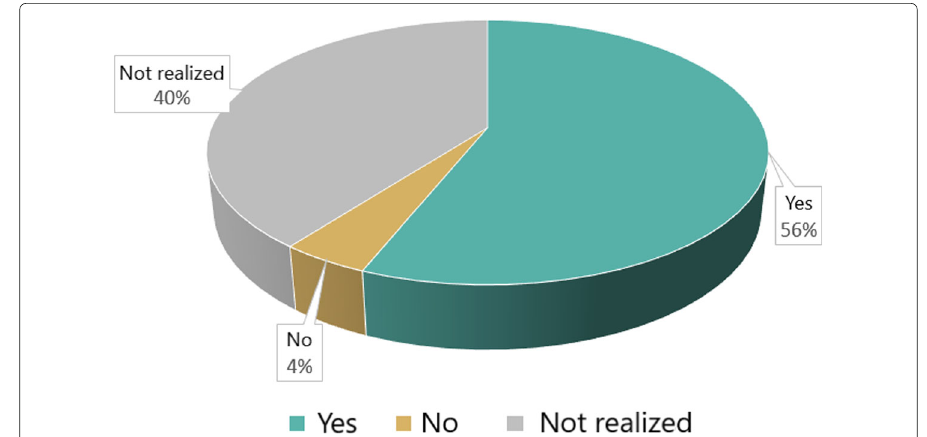
Fig. 7 User satisfaction. Answers to the question about user satisfaction when using the visualization tool. (source: (Ferreira et al.